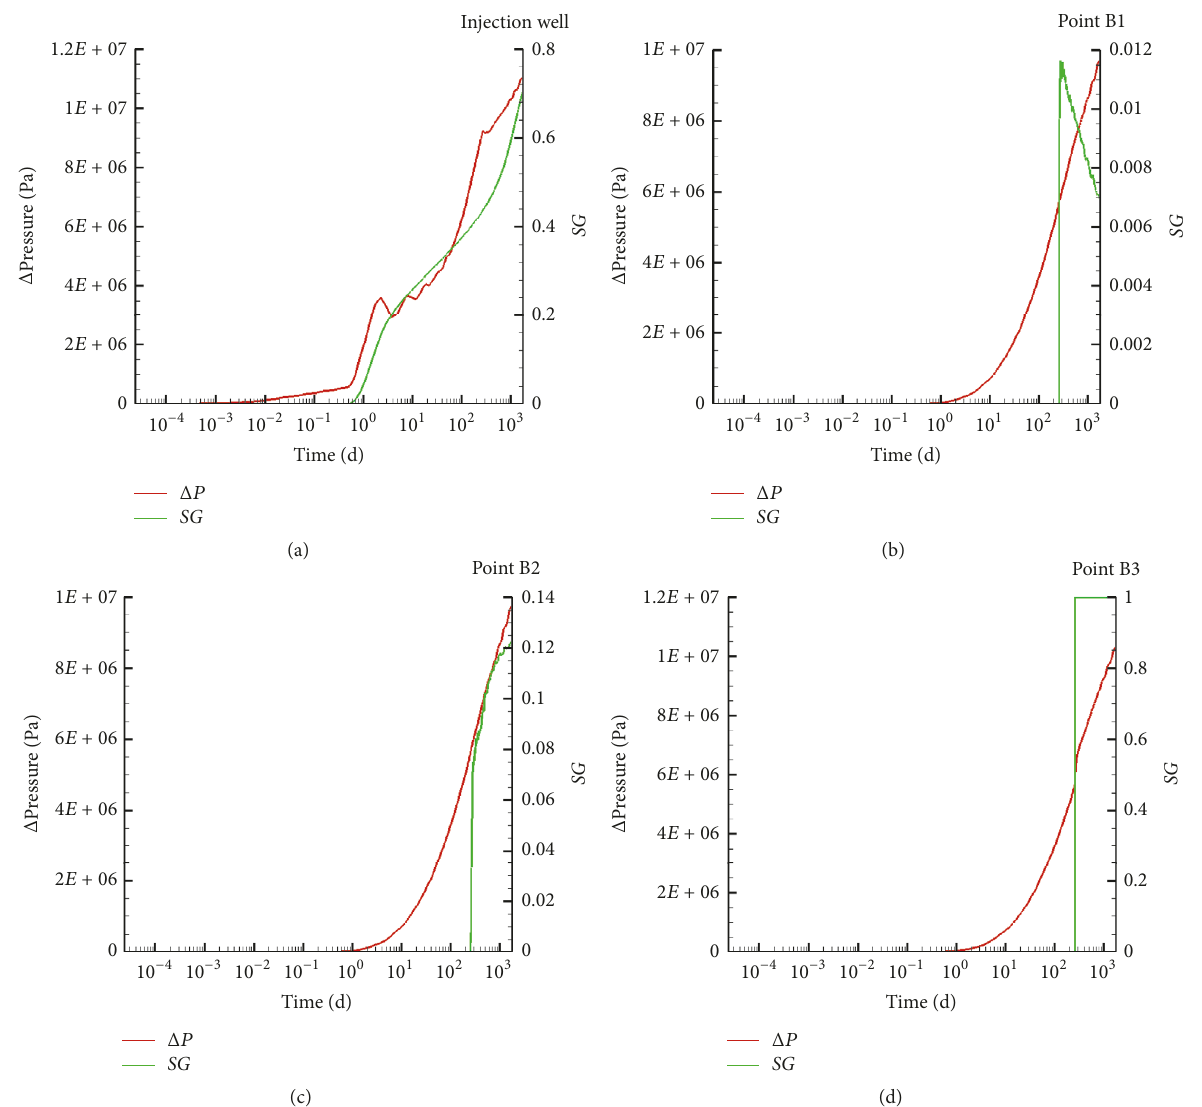
Figure 4: Pressure buildup and gas saturation changes at injection well and monitor points during CO 2 injection in Case 1.